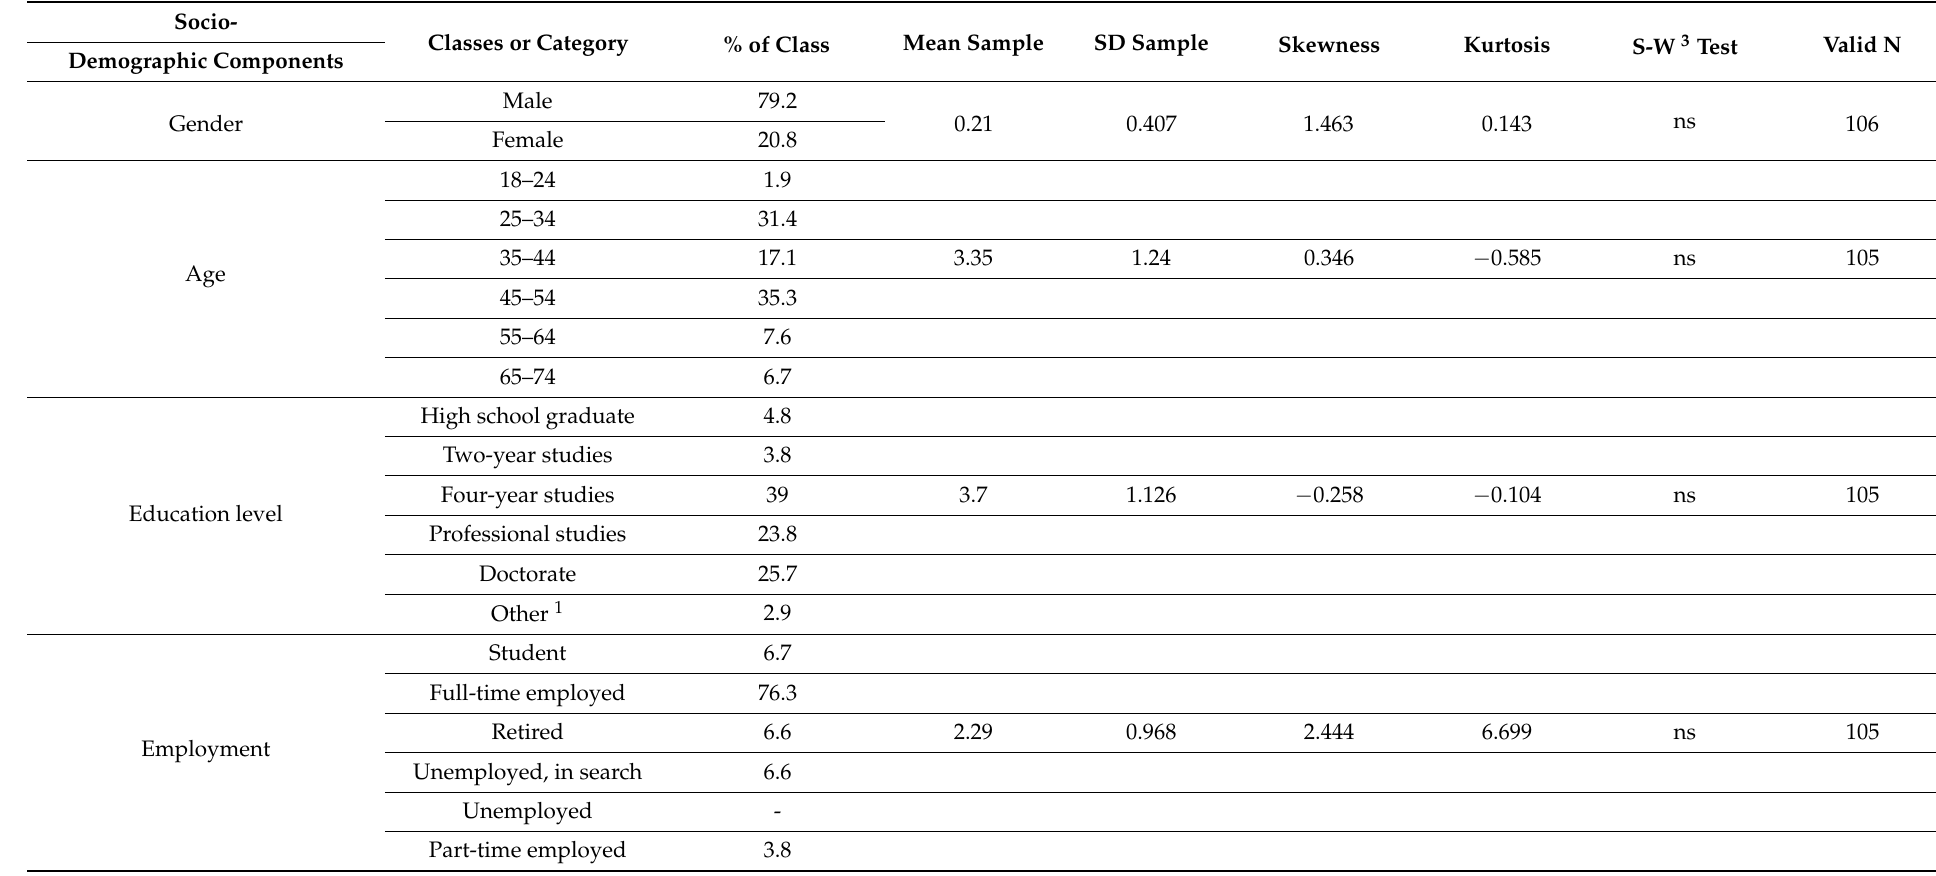
Table 2. Socio-demographic component results of the respondents with basic statistical